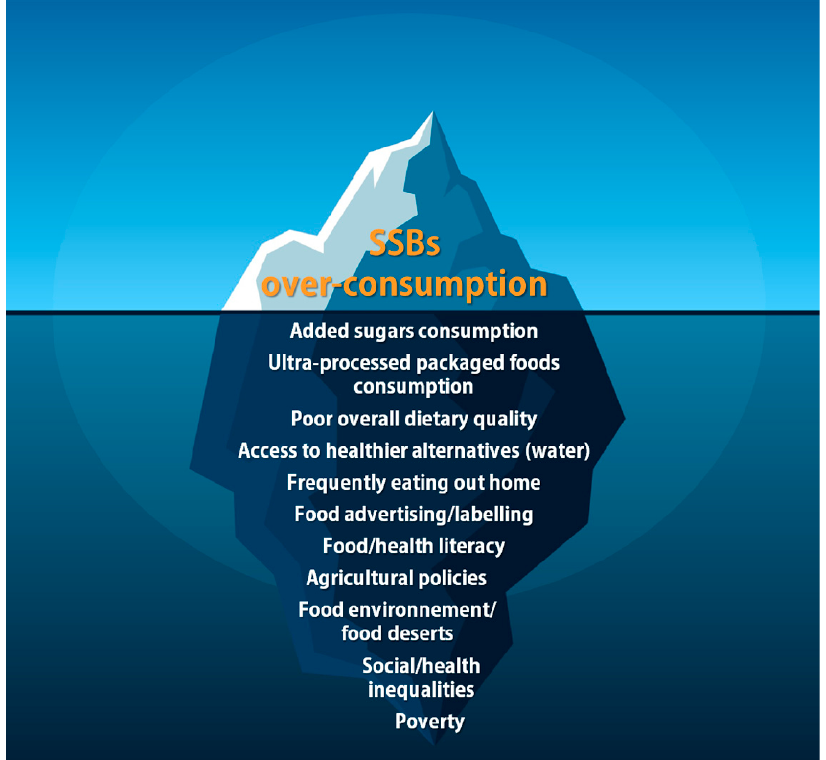
Figure 1. Schematic representation of factors associated with sugar-sweetened beverage (SSB)